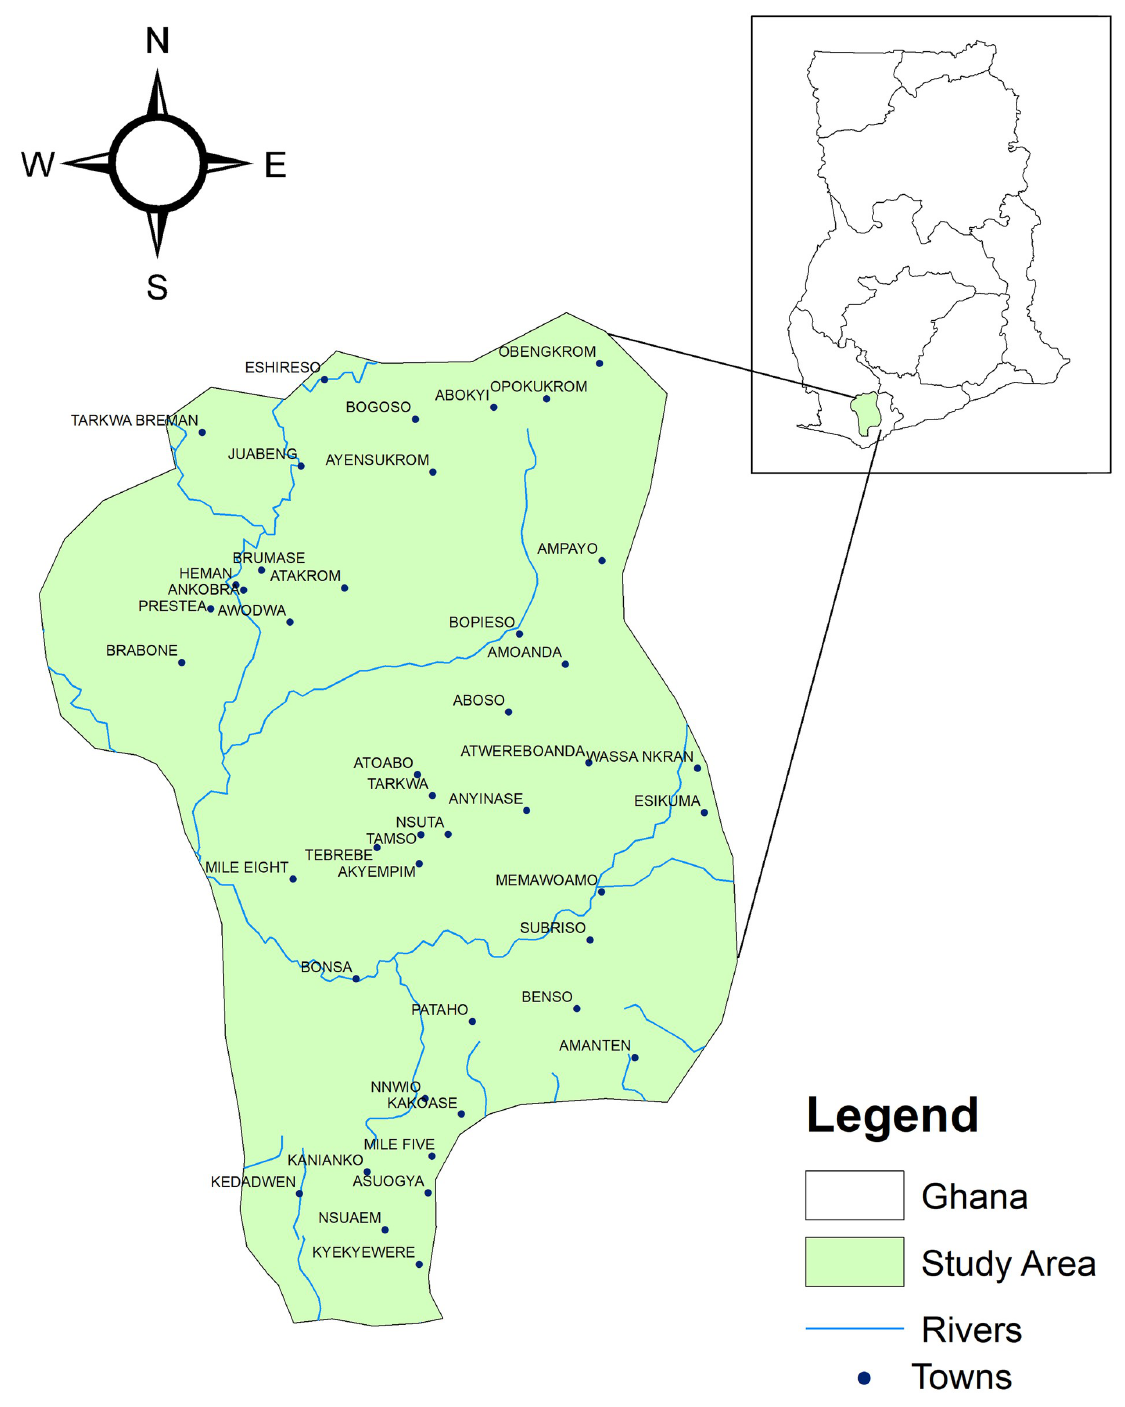
Fig 1. Map of the study